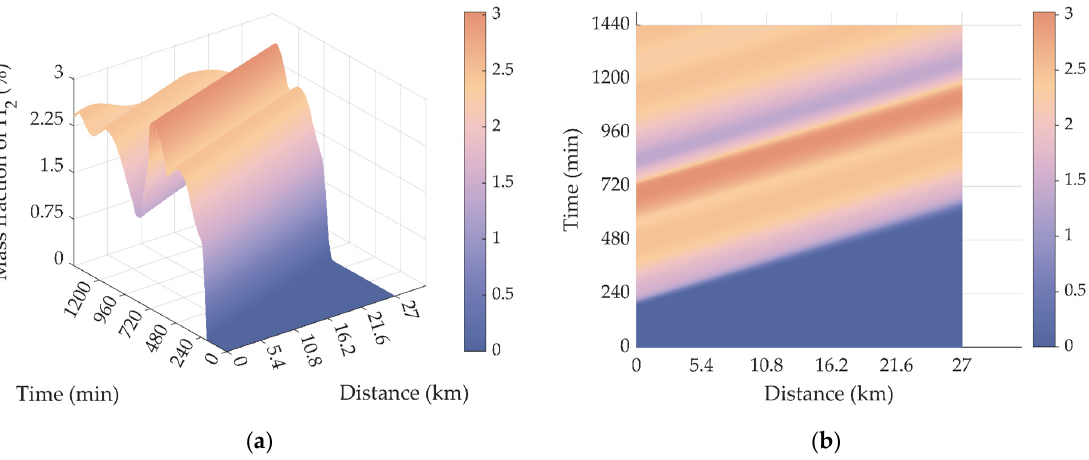
Figure 16. The distribution of hydrogen mass fraction in Pipe 6 in Scenario II: ( a ) Three-dimensional diagram; ( b ) top view.